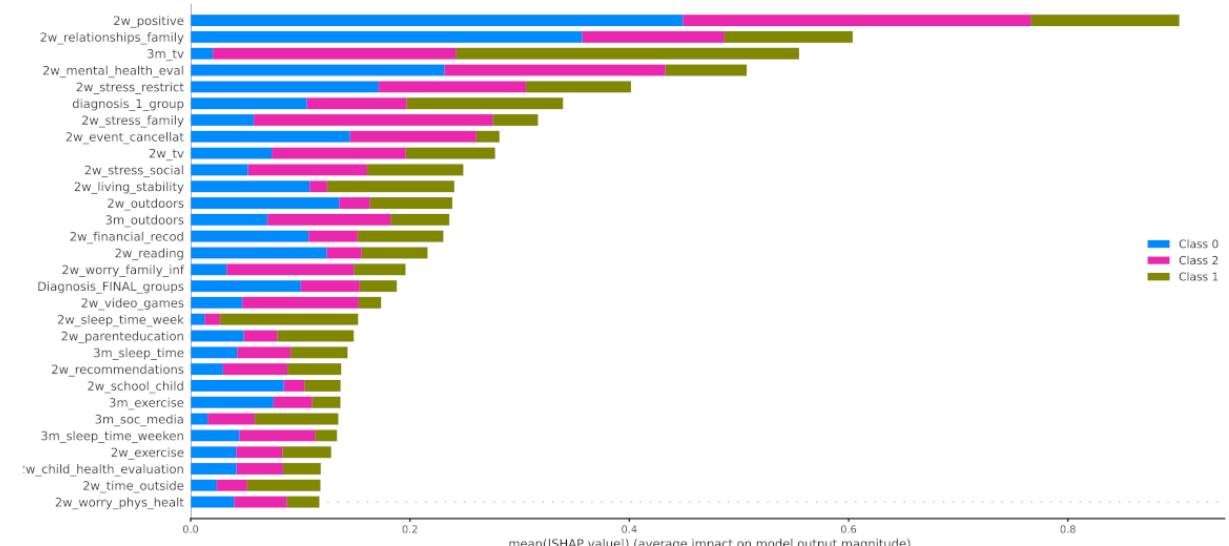
Figure 12. Mean SHAP values.